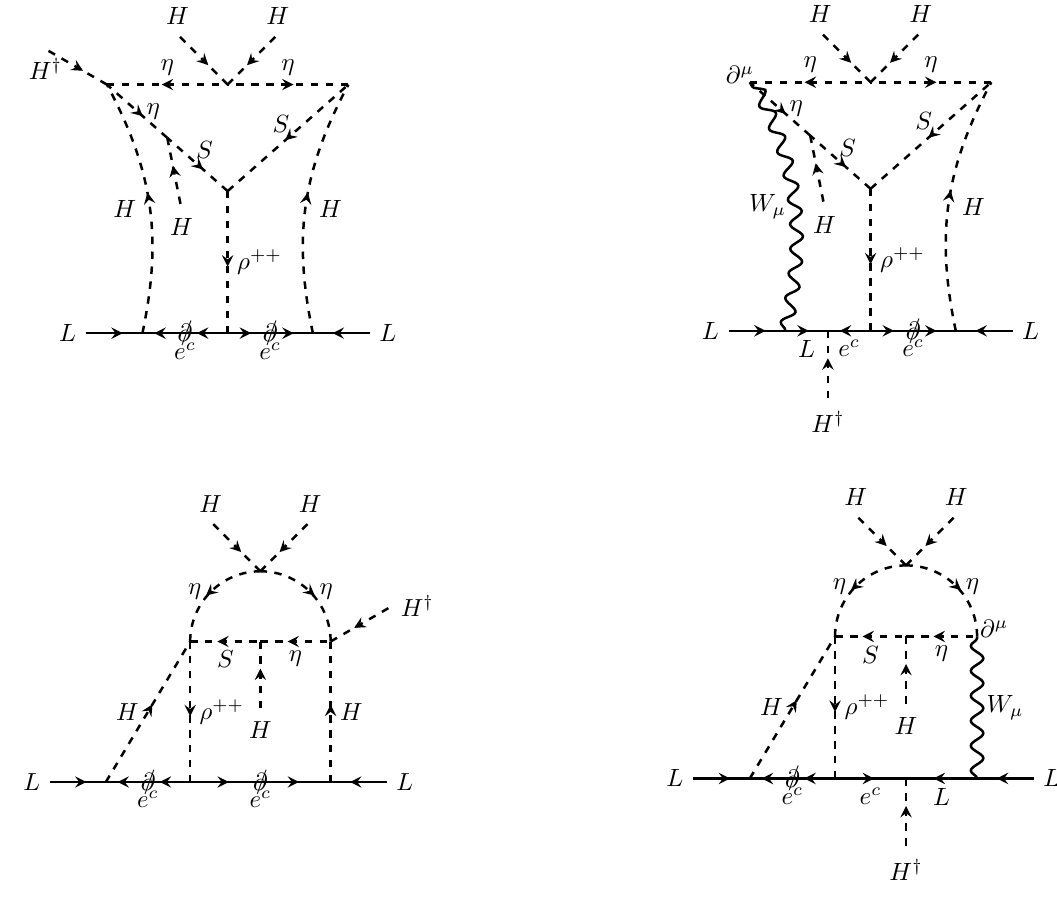
Figure 19 . Dimension 7 mass diagrams in the gauge basis. W scalars, so every diagram has the same number of derivatives. We will use the notation I (7) i = 1 ; 4 following the usual order from left to right and top to bottom.